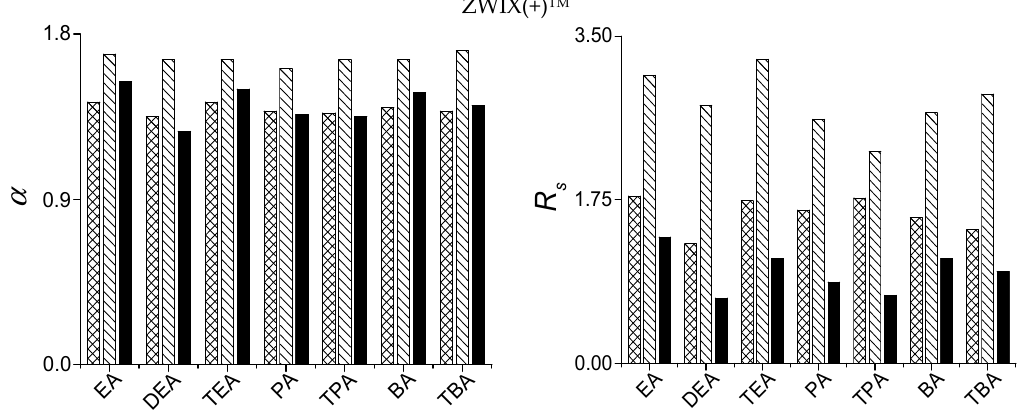
Figure 4. Effects of the natures of base additives on the chromatographic parameters of α and R S of Fmoc-Asp(O t Bu)-OH, Fmoc-Lys(Boc)-OH and Fmoc-Phe-OH. Chromatographic conditions: columns, ZWIX(+)™; mobile phase, H 2 O/MeOH (1.0/99.0 v/v ) containing 3.75 mM base and 7.5 mM AcOH; flow rate, 0.6 mL·min − 1 ; detection, 262 nm. Symbols: for Asp(O t Bu)-OH; for Fmoc- Lys(Boc)-OH; and Fmoc-Phe-OH.